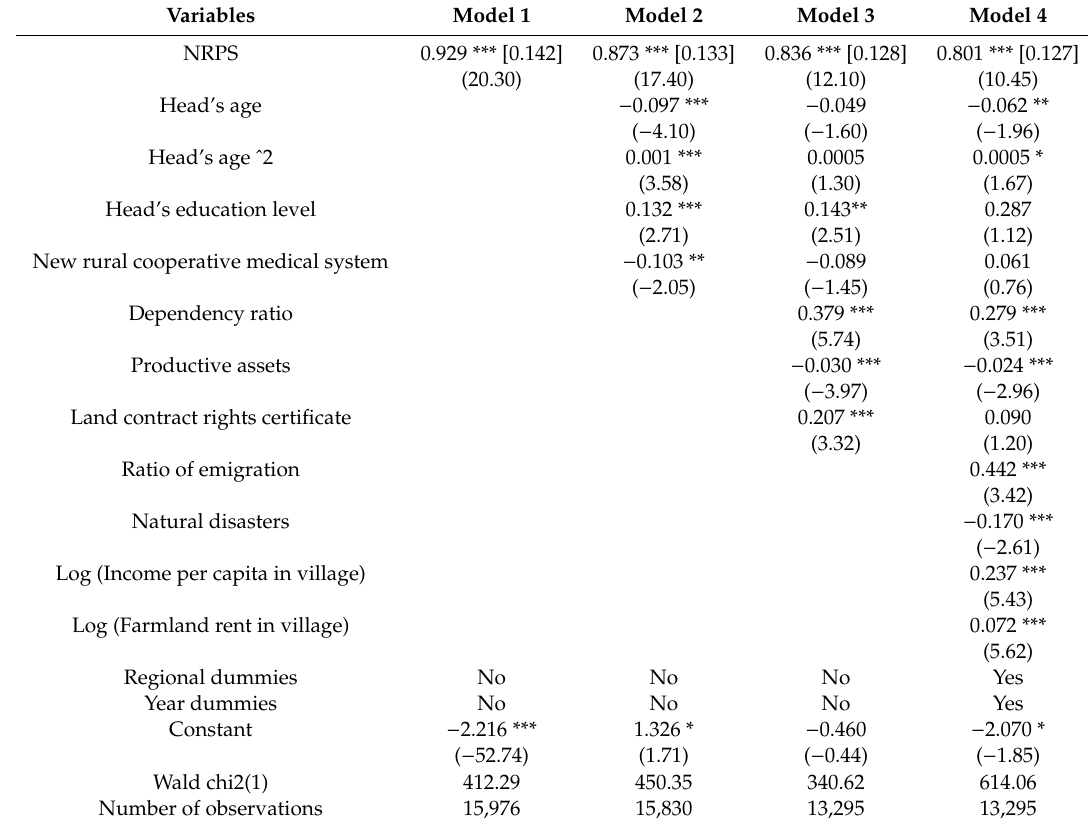
Table 5. Impact of NRPS on the probability of transferring